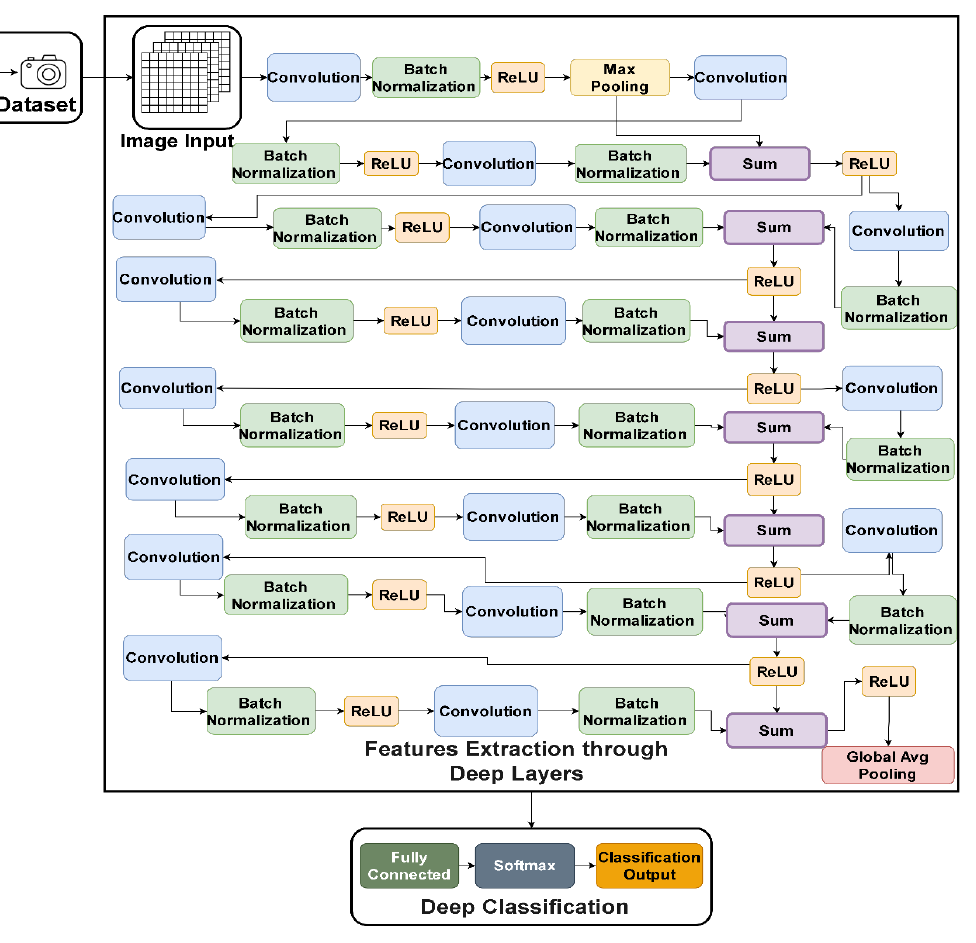
Figure 4. Transfer learning on a pre-trained network.